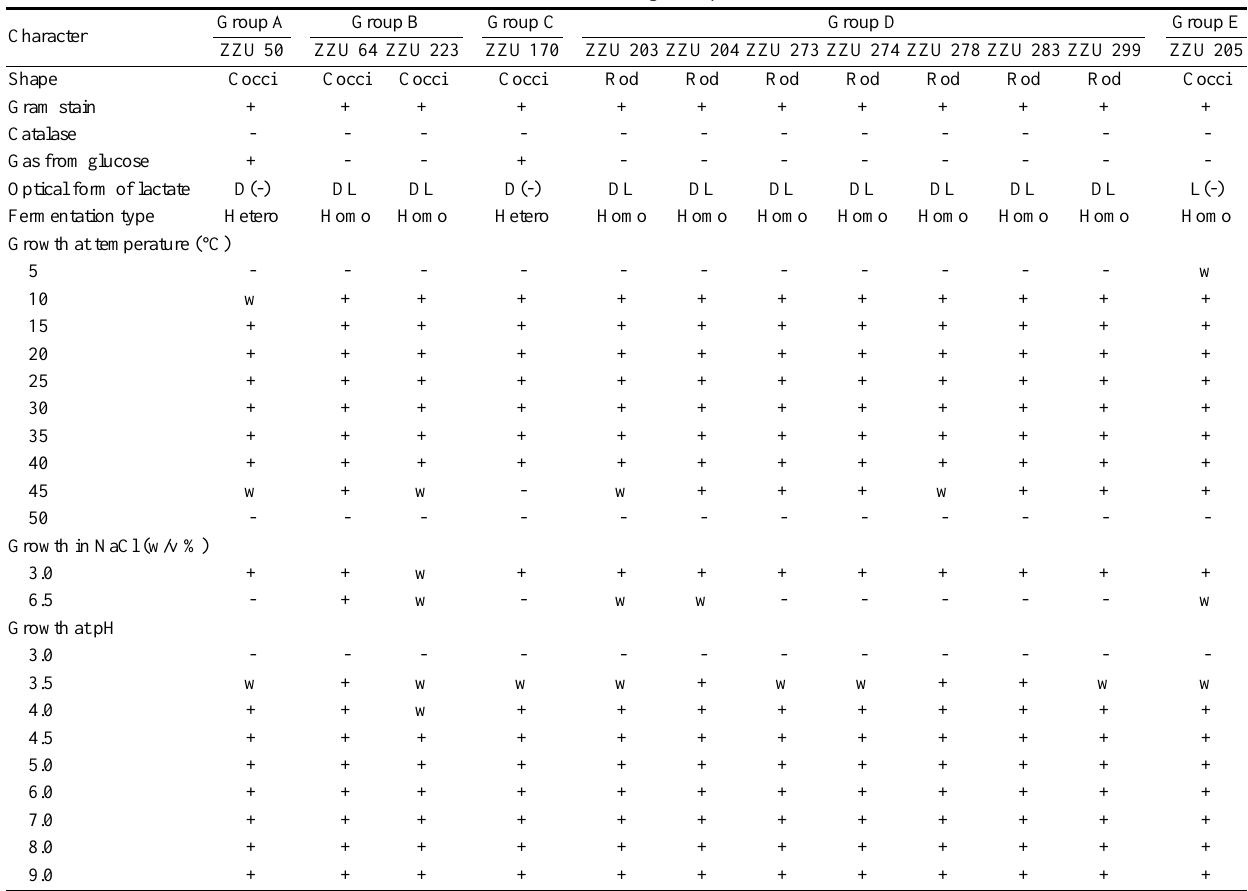
Table 2. Characteristics of lactic acid bacteria strains isolated from silage